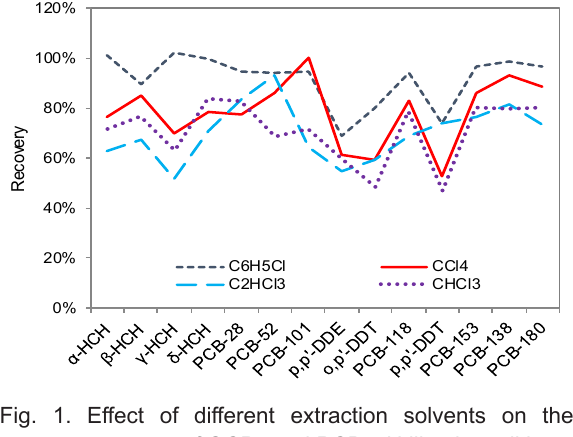
Fig. 1. Effect of different extraction solvents on the recovery of OCPs and PCBs. Utilized conditions: water volume: 5.0 mL, concentration of spiked standard: 25 μg/L, extraction time: 30 min, cetrifugation time: 10 min.